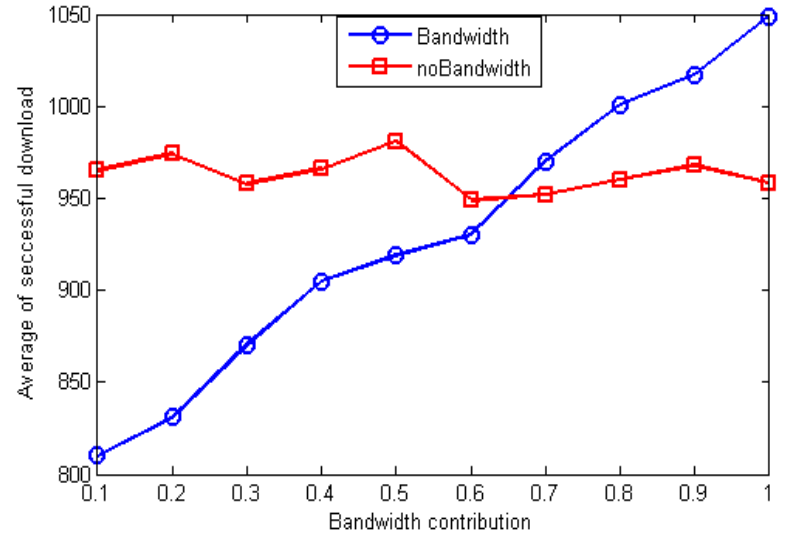
Figure 10. Effect of bandwidth contribution